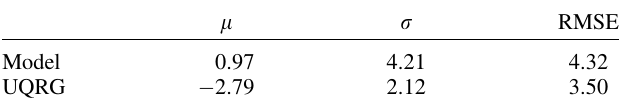
Table 5. Summary of the performance against JASON-3 for 8th February 2018. Upper row: forecasting model. Lower row: UQRG